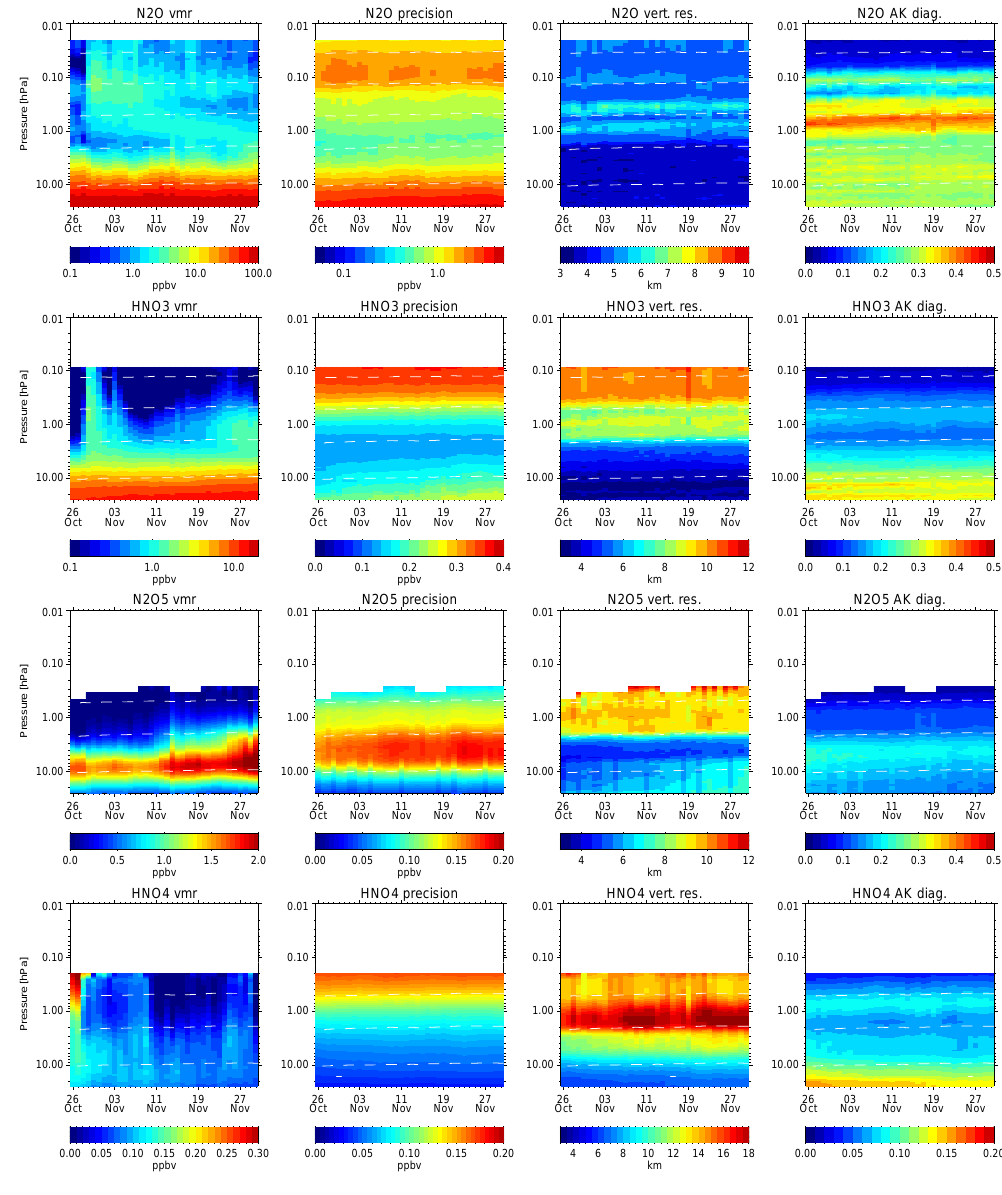
Fig. 2. Same as Fig. 1, but for N 2 O, HNO 3 , N 2 O 5 , and HNO 4 . Fig. 2. Same as Figure 1, but for N 2 O , HNO 3 , N 2 O 5 , and HNO 4 . data are obtained in the whole vertical range of interest (25–70 of November are visible in Figure 2, consistent with previ-